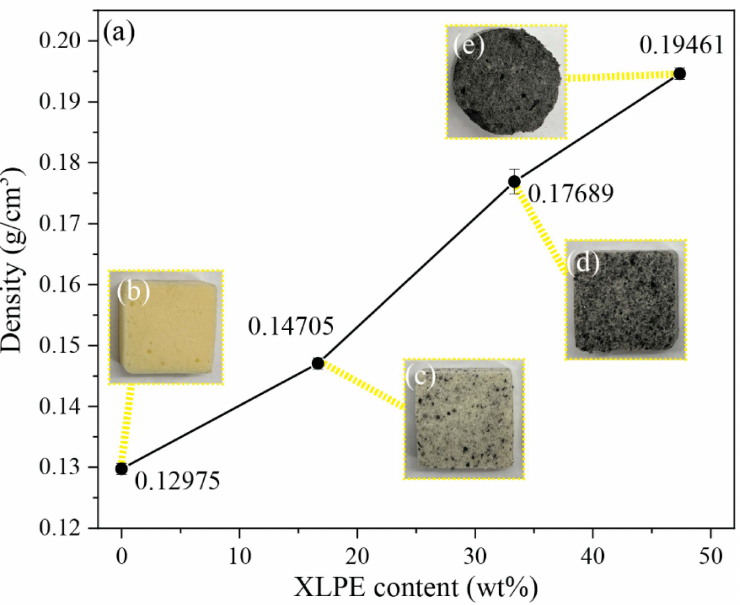
Figure 4. ( a ) RPUF/XLPE density measurements for samples ( b ) RPUF, ( c ) RPUF/XLPE 16.67 wt%, ( d ) RPUF/XLPE 33.33 wt%, and ( e ) RPUF/XLPE 47.37 wt%.